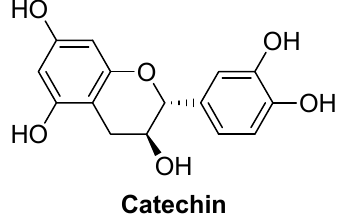
Figure 42. Catechin.